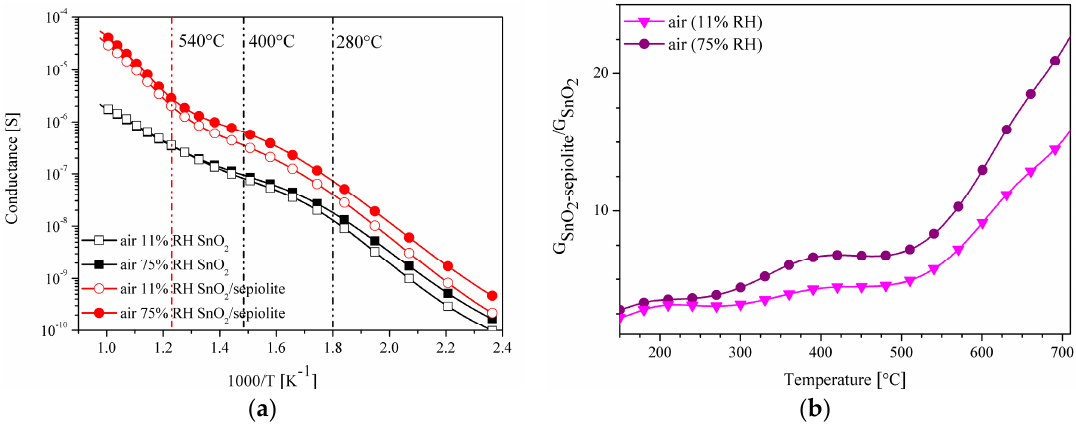
Figure 14. ( a ) Changes in the conductance of SnO 2 sensor with and without a sepiolite filter as a